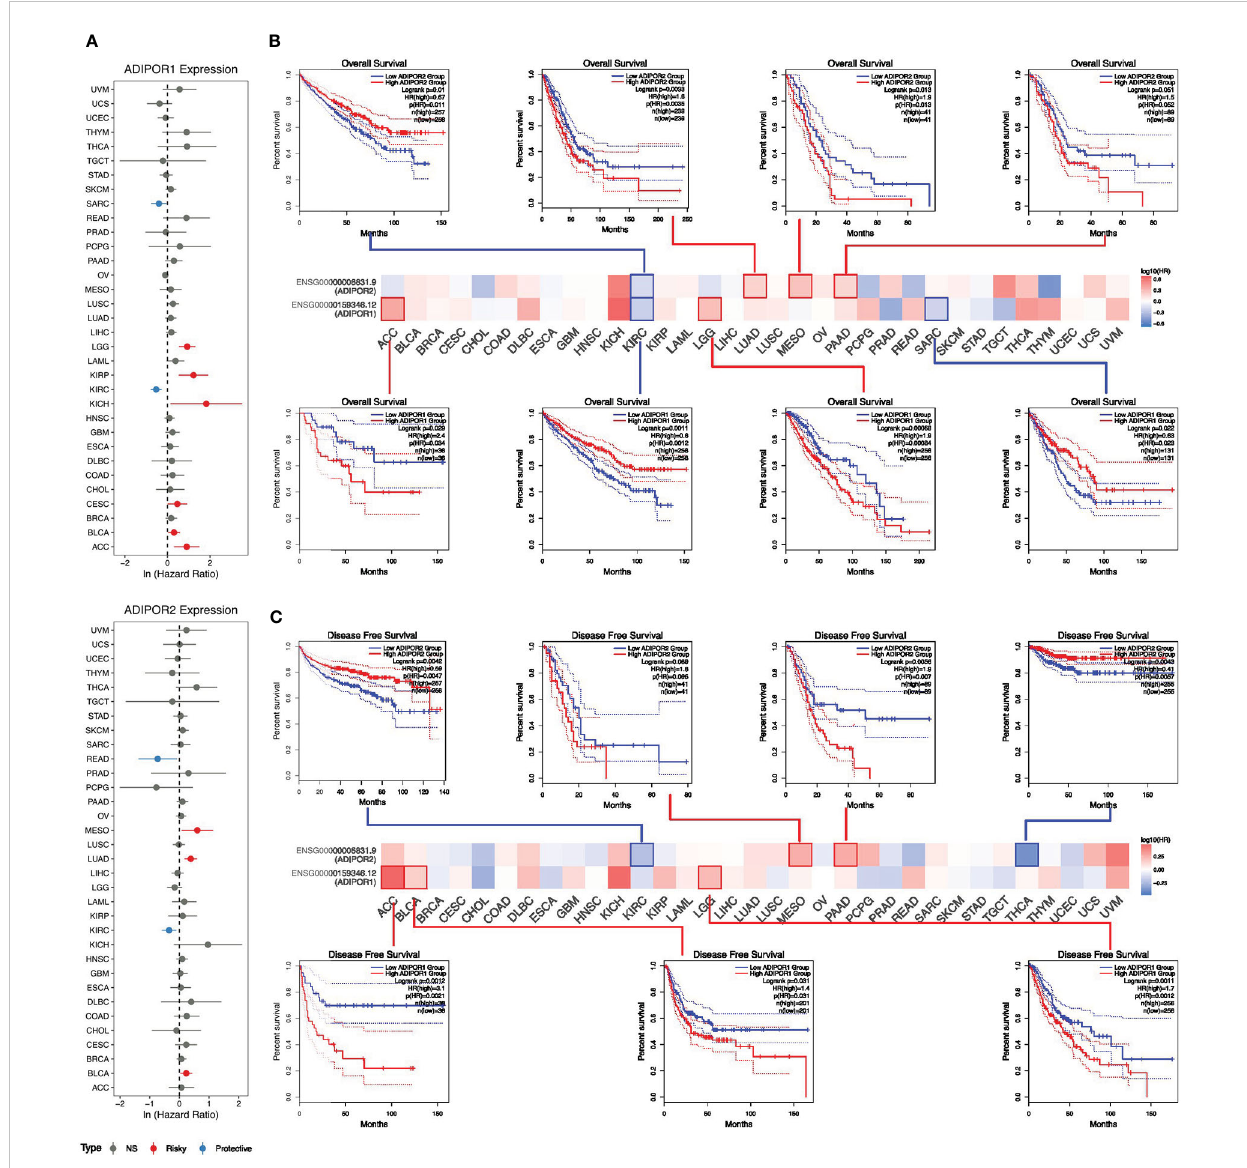
FIGURE 4 The roles of ADIPOR1 and ADIPOR2 in cancers. (A) The univariate cox analysis for ADIPOR1 and ADIPOR2. (B) The overall survival analysis for ADIPOR1 and ADIPOR2. (C) The disease free survival analysis for ADIPOR1 and